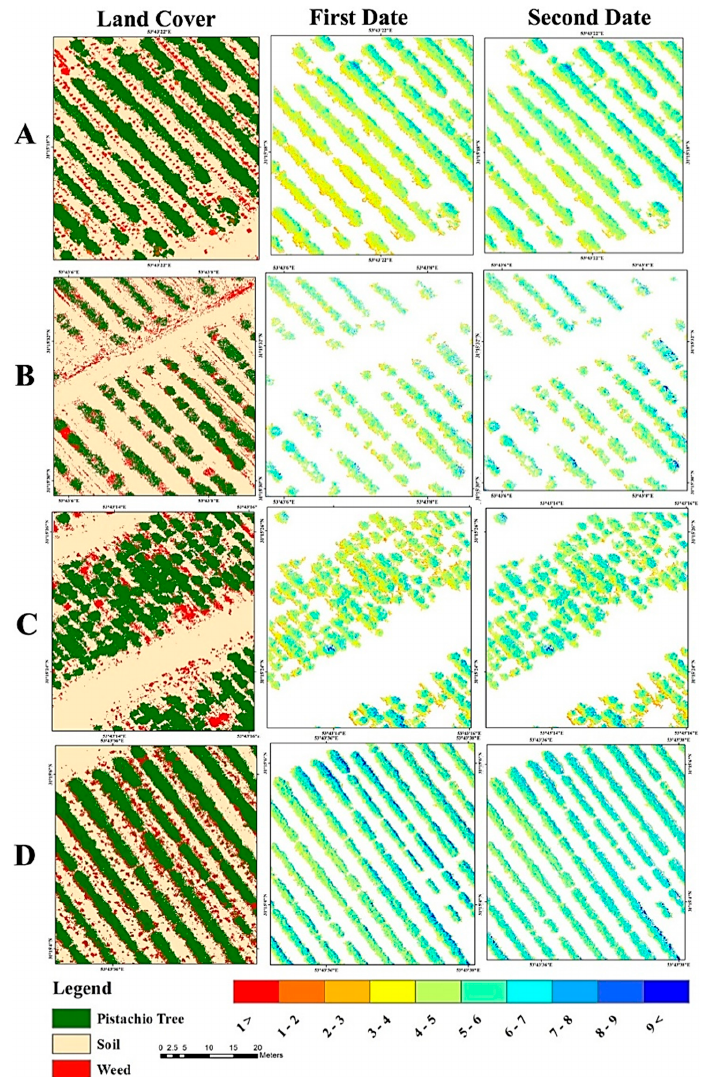
Figure 8. Daily evapotranspiration by pistachio trees after foliar application of gypsum on the first imaging date (plot ( A ) only) and of gypsum again, gypsum, NAX-95 (calcium-based suspension coating), and sulfur in plots ( A ), ( B ), ( C ), and ( D ), respectively, on the second date. Before foliar application of gypsum in plot B, 80% of the tree area showed daily evap- otranspiration of <0.5 mm/day, while after application this proportion decreased to 50% of tree area and the remaining tree area showed increased evapotranspiration. Before fo- liar application of NAX-95 (calcium-based suspension coating) in plot C, 62% of the pis- tachio tree area showed daily evapotranspiration of <0.5 mm/day, while after application the proportion was 54%. In general, foliar application of NAX-95 (calcium-based